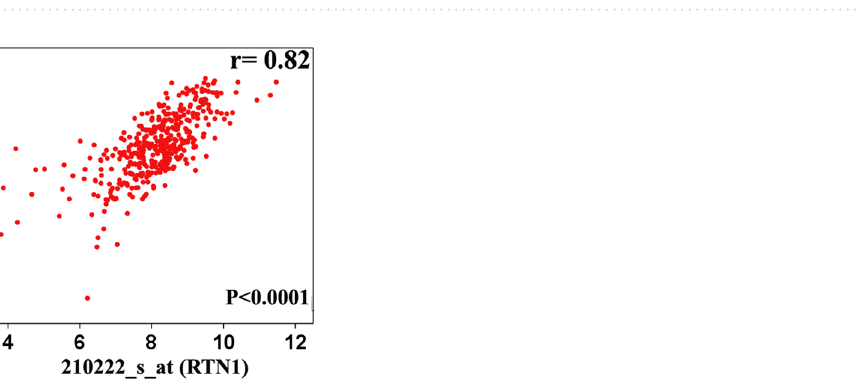
Figure 4. Representing scatterplot depicting the correlation between various BCL2L1 probe-sets (x-axis) and RTN1 probe-sets (y-axis) in GSE10846. The correlations between pairs of probes were poor and inconsistent (negative and positive correlations). Correlation analysis for other datasets was presented in Supplementary Table 2.